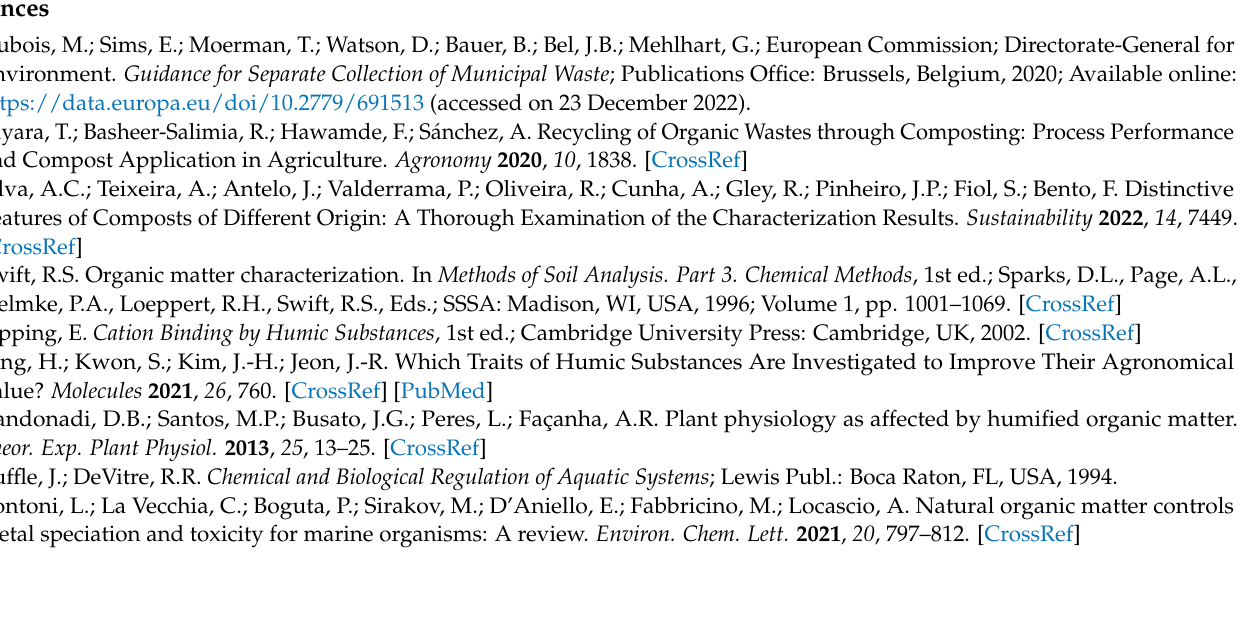
extracts. Table S1: Abundance of deprotonated groups at pH 7.0 ( Q pH 7 . 0 ) and the abundance of acid sites of the extracts HA, FA, and DOM ( M T , M T,HS and M T,DOM ). The abundance of acid sites of the extracts was calculated using Equations (S3) and (S4); Table S2: Identification of the compost and fertiliser samples characterized in the present work; Table S3: Carbon content of the extracts HA, FA, and DOM and yield ( Y ) of the extractions of HA and FA. The carbon content of each extract was calculated using Equations (S1) and (S2); Table S4: Data from elemental composition of the compost and fertiliser